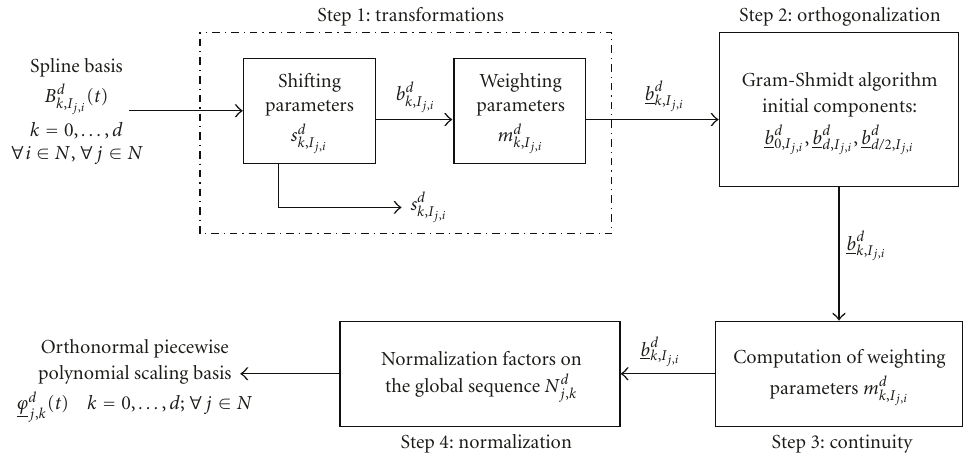
Figure 4: Global orthonormalization